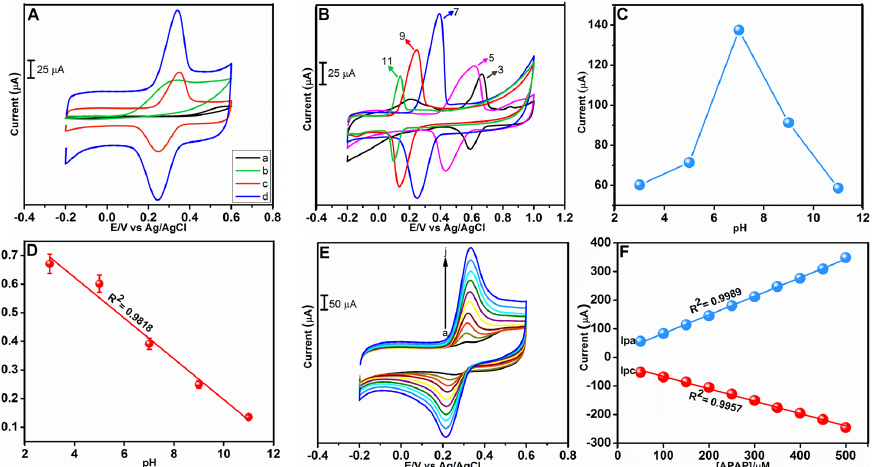
Figure 5. ( A ) CV curves of unmodified SPCE (a), AgCuO NPs/SPCE (b), fCNTs/SPCE (c), and AgCuO NPs/fCNTs/SPCE (d) in the presence of 200 µ M APAP at 0.1 V/s. ( B ) CV curves of AgCuO NPs/fCNTs/SPCE at different pH. ( C ) pH vs. oxidation peak current. ( D ) pH Vs. oxidation peak potential. ( E ) CV curves of AgCuO NPs/fCNTs/SPCE during continuous APAP addition from 50 µ M to 500 µ M (a–j). ( F ) Anodic peak currents ( I pa ) and cathodic peak currents ( I pc ) against APAP